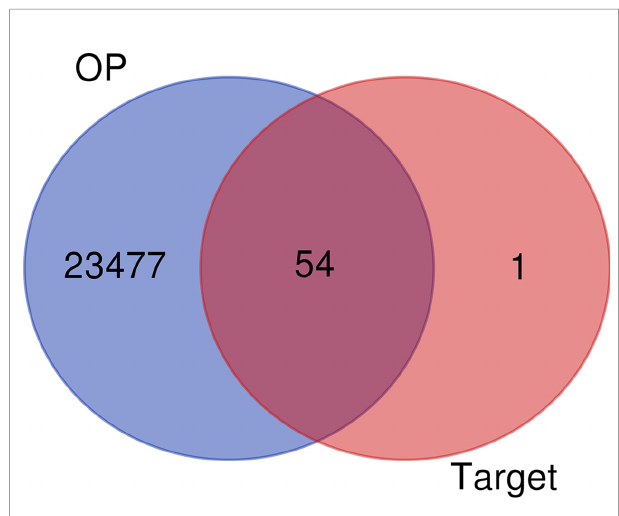
FIGURE 2 | Venn diagram of Luteolin targets and OP-related targets.